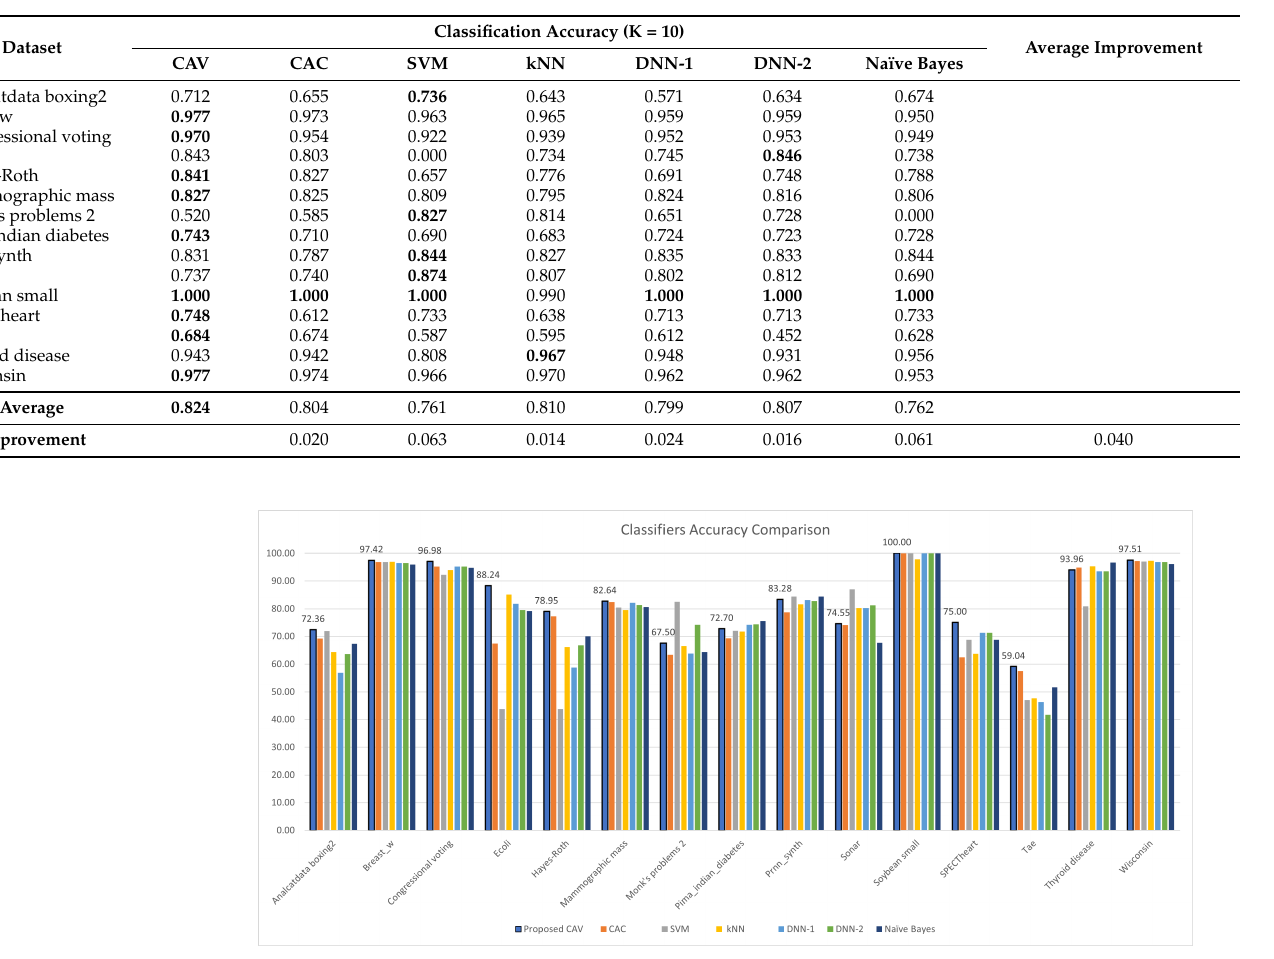
Table 9. The G-mean of the proposed CAV compared with CAC, SVM, k-NN, DNN-1, DNN-2, and naïve Bayes (the bold number indicates the maximum value).